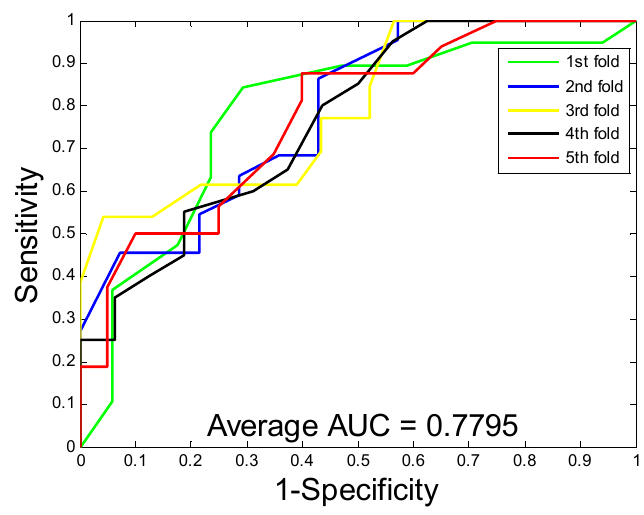
Figure 3. The ROC curves are generated by our method on GPCR dataset.